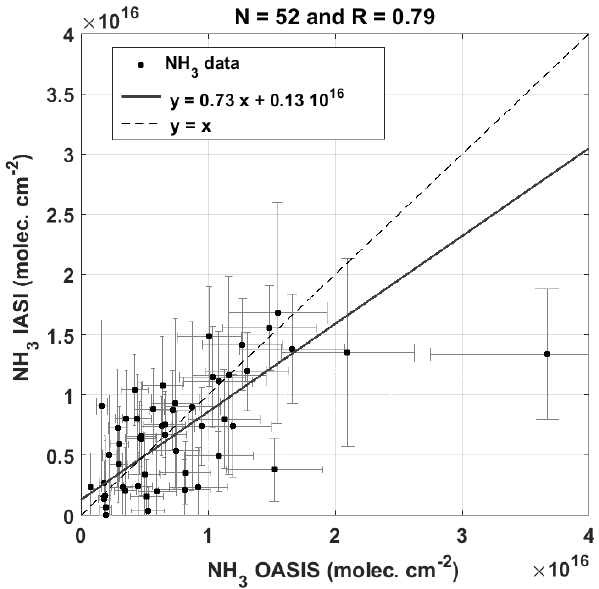
Figure 6. Correlations between the FTIR–OASIS and NH 3 –IASI total columns fulfilling the following temporal and spatial coinci- dence criteria: a time difference smaller than 30min and a 15km radius centered on the ground-based FTIR station. The broken line is the straight equation with slope